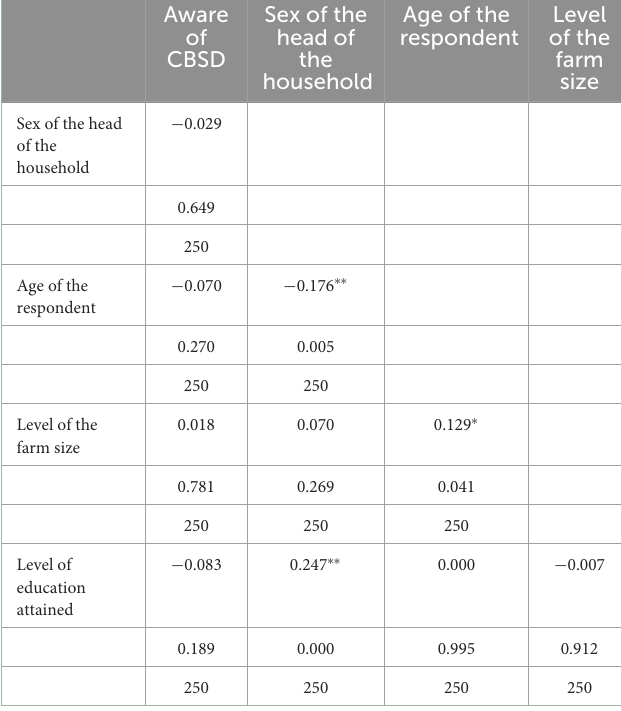
Aware Sex of the Age of the Level of head of respondent of the CBSD the farm household